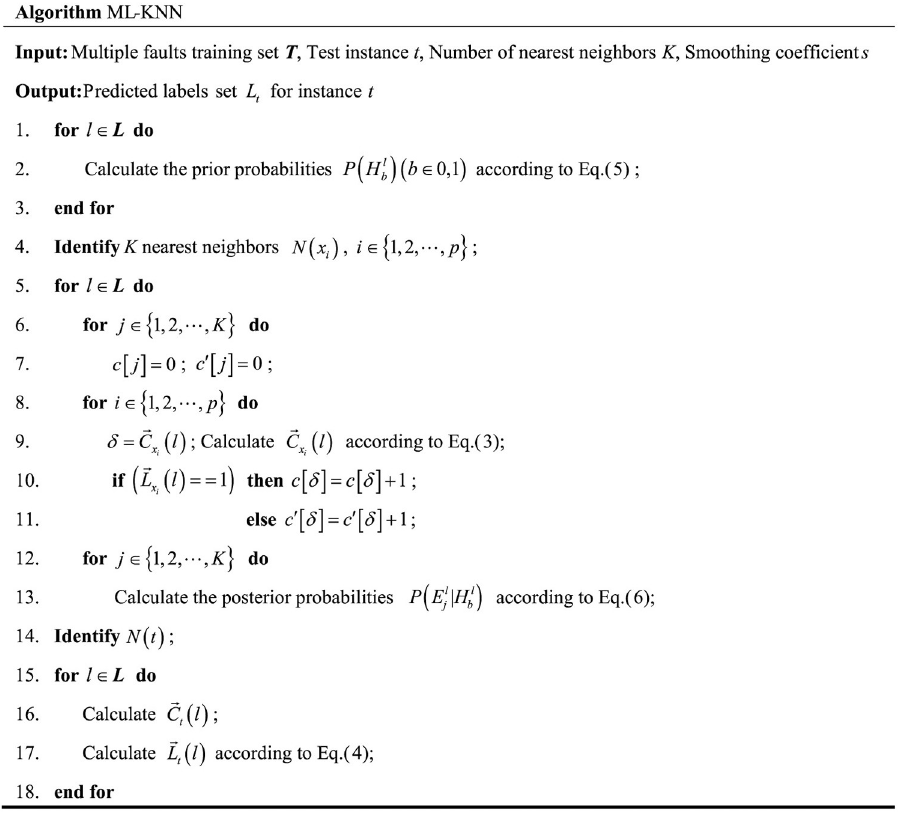
Fig 3. Pseudo-code of the ML-KNN